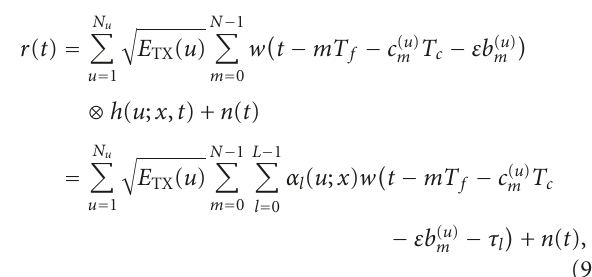
Figure 2: Time and frequency domain representations of a second derivative Gaussian monocycle with centre frequency of 3.9